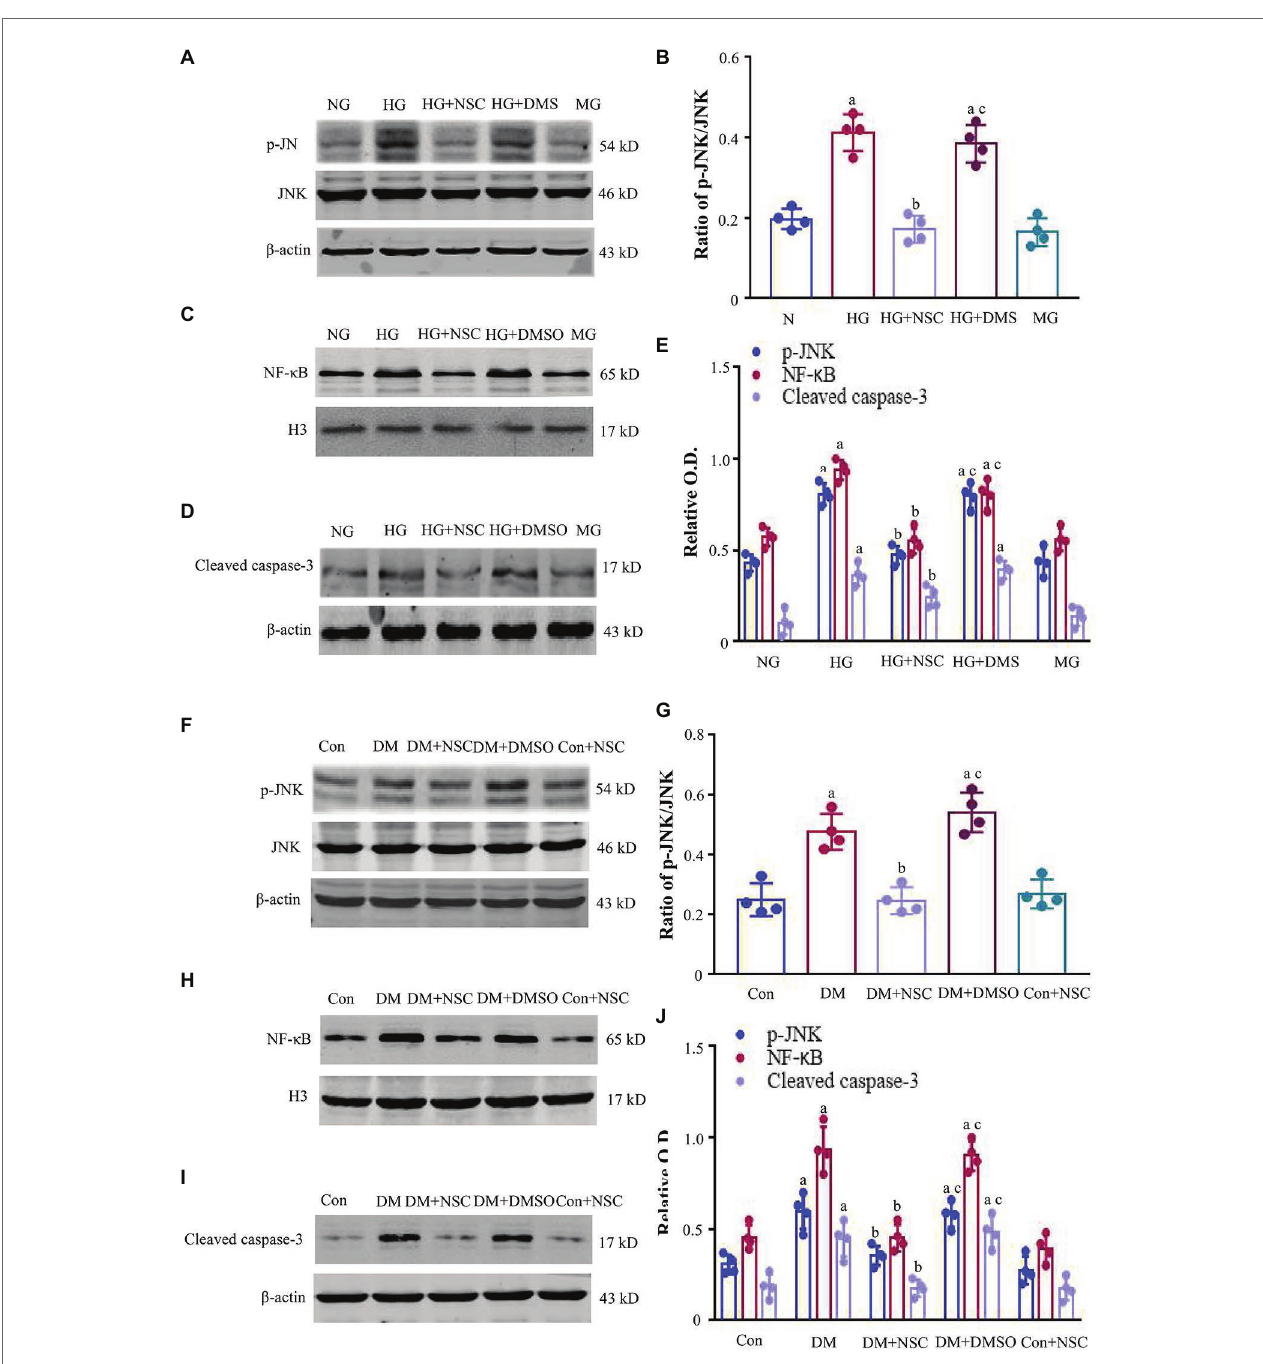
FIGURE 4 | Expression of c-Jun N-terminal kinase (JNK), nuclear factor- κ B (NF- κ B), and cleaved caspase-3. (A) Typical bands of phosphorylated c-Jun N-terminal kinase (p-JNK) and JNK were shown. (B) The ratio of p-JNK/JNK was analyzed. (C,D) Typical bands of NF- κ B and cleaved caspase-3 in HEK-293 T cells. (E) Analysis of optical density (OD) values of protein expression. (F) Representative bands present the expression of p-JNK and JNK. (G) The ratio of p-JNK/JNK was analyzed. (H,I) Representative bands showing the levels of NF- κ B, and cleaved caspase-3 in renal tissues. (J) Bands calculated by OD analysis. Results are presented as mean ± SD. a p < 0.05 vs. the NG group (B,E) and the Con group (G,J) ; b p < 0.05 vs. the HG group (B,E) and the Con group (G,J) ; c p < 0.05 vs. the HG + NSC group (B,E) and the DM + NSC group ( G and J ). n = 4 in each